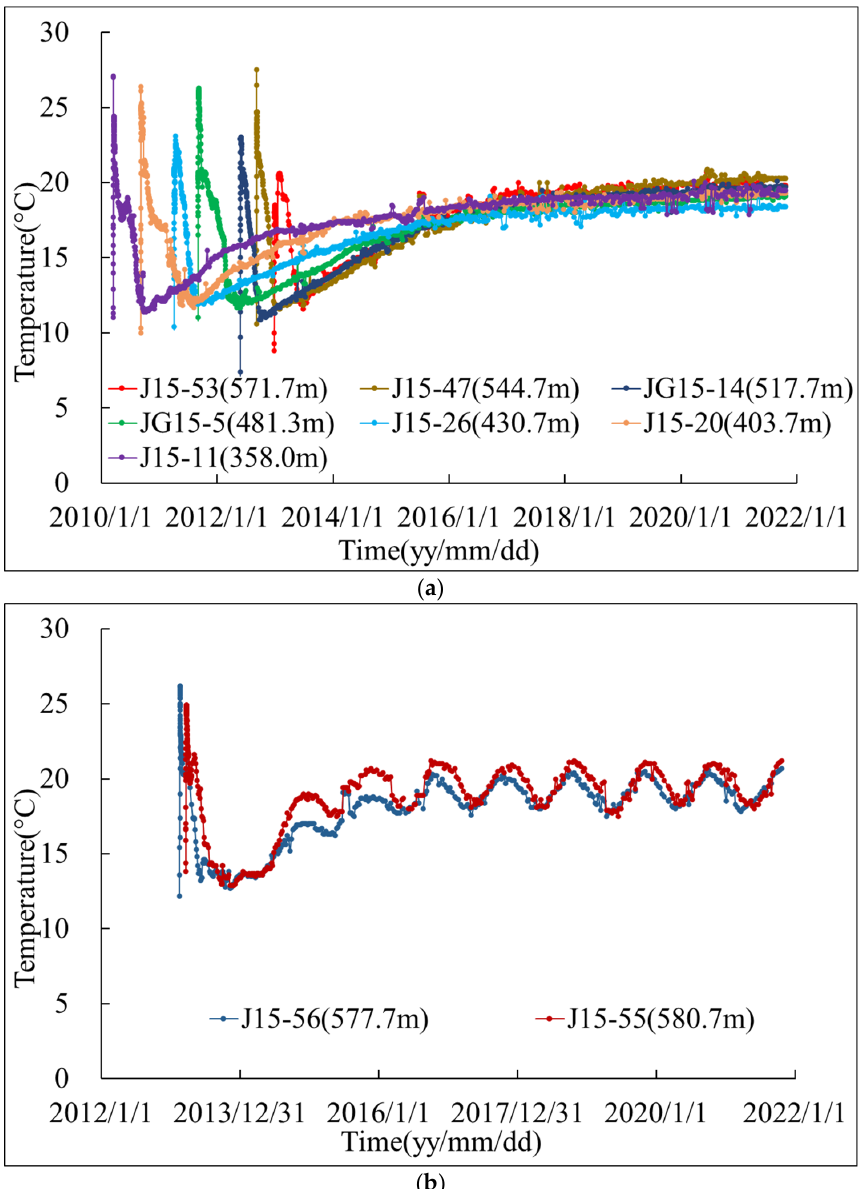
Table 3. From the spatial distribution characteristics, the temperature inside the dam dur- ing operation gradually tended to be stable below the elevation of 571.7 m, and it changed periodically with time above the elevation of 571.7 m, ranging from 17.5 °C to 21 °C.